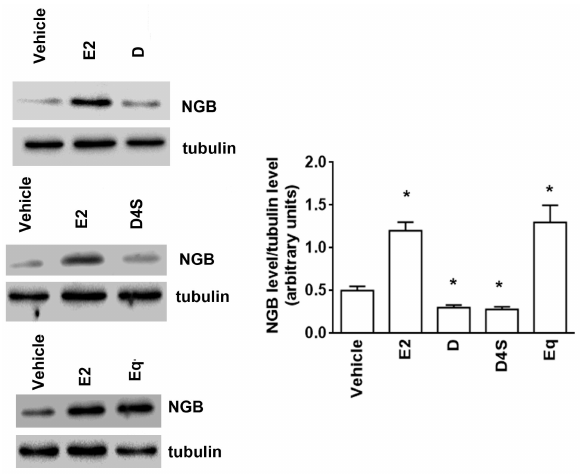
Figure 2. E ff ects of daidzein, daidzein-4 (cid:48) -sulfate and equol on neuroglobin intracellular levels in T47D cells. Western blot (left) and densitometric analyses (right) of NGB protein levels in T47D cells treated for 24 h with the vehicle (DMSO), E2 (10 nM), D (1 µ M), D4S (1 µ M), or Eq (1 µ M). The amount of proteins was normalized by comparison with tubulin levels. Data are the mean ± SD of three di ff erent experiments. p < 0.001 was determined with Student t-test with respect to the vehicle (*) treated samples. DMSO: dimethyl sulfoxide; E2: estradiol; NGB: neuroglobin; D: daidzein; D4S: daidzein-4 (cid:48) -sulfate; Eq: